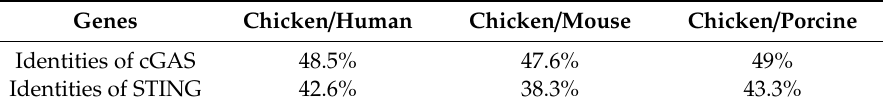
Table 1. Homology analysis of chcGAS and chSTING across